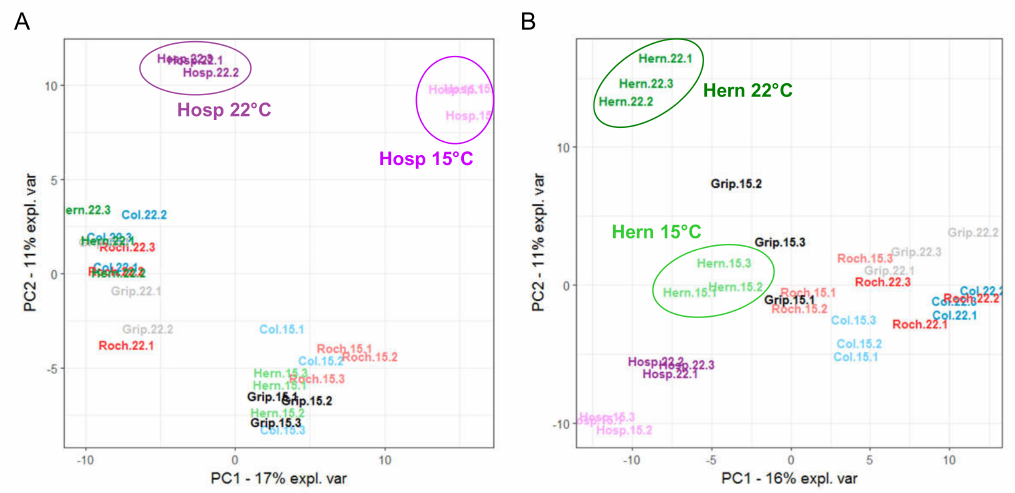
Figure 4. Overall comparison of the cell wall (CW) proteomes of Col, Roch, Grip, Hern and Hosp grown at 22 ◦ C (bright colors) or 15 ◦ C (pale colors). Scaled PCA of the proteomic quantitative analysis: ( A ) rosettes; ( B ) floral stems. The ellipses focus on the specific profiles discussed in the Results